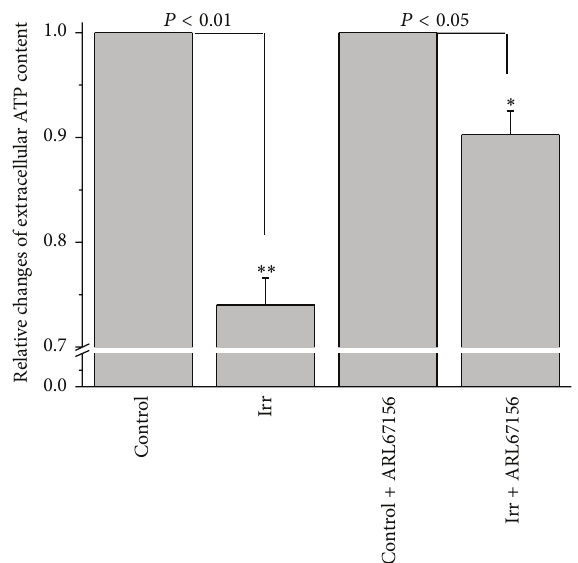
Figure 6: Extracellular ATP content of rat DRG neurons in response to 657 nm, 18mW/cm 2 , and 21J/cm 2 laser irradiation. Relative changes of extracellular ATP level of rat DRG neurons induced by laser irradiation averaged for respective irradiation times of all samples. The data represent averages ± SEM from 𝑁 = 3 – 7 independent experiments. ∗∗ 𝑃 < 0.01 compared to the preirradiation value; ∗ 𝑃 < 0.05 compared to the preirradiation in the presence of ARL 67156